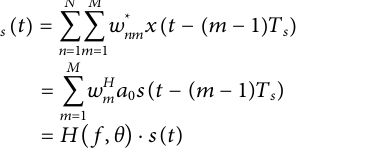
FIGURE 2 Equivalent fi lter structure diagram of